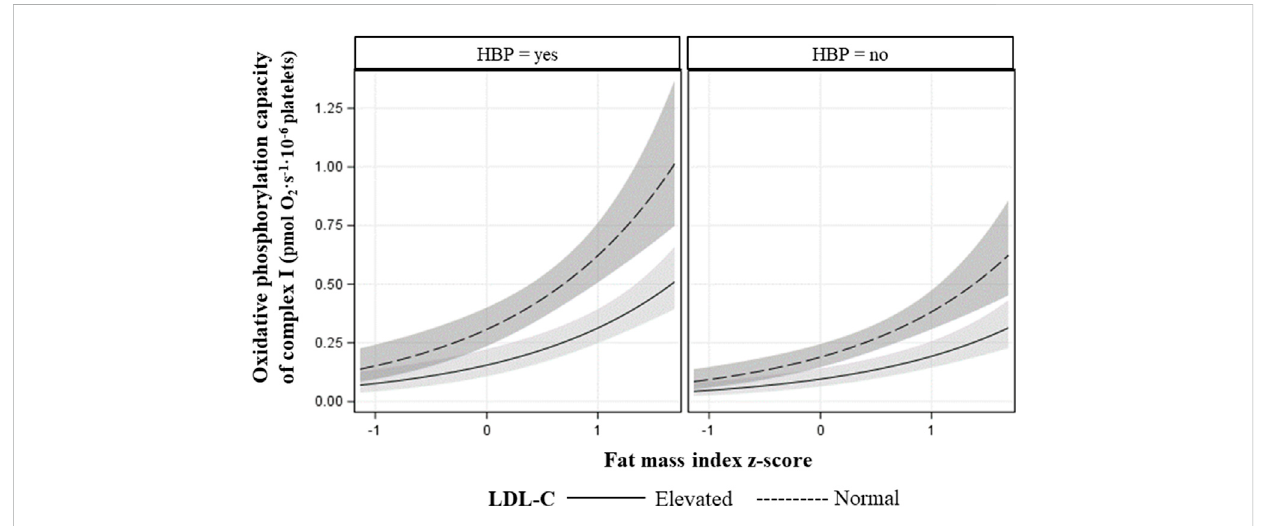
Fitted plot showing the association of CI maximal oxidative phosphorylation capacity plus 95% con fi dence intervals with fat mass index z-score (x-axis), LDL-cholesterol status, and blood pressure status (HBP = high blood